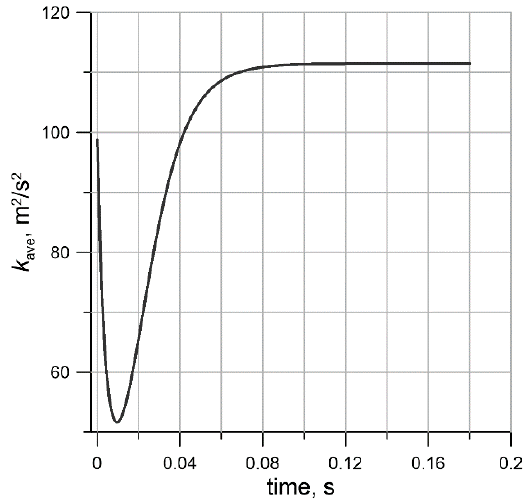
k with 0.61 C = on the mesh with 64 3 ave 2 DES